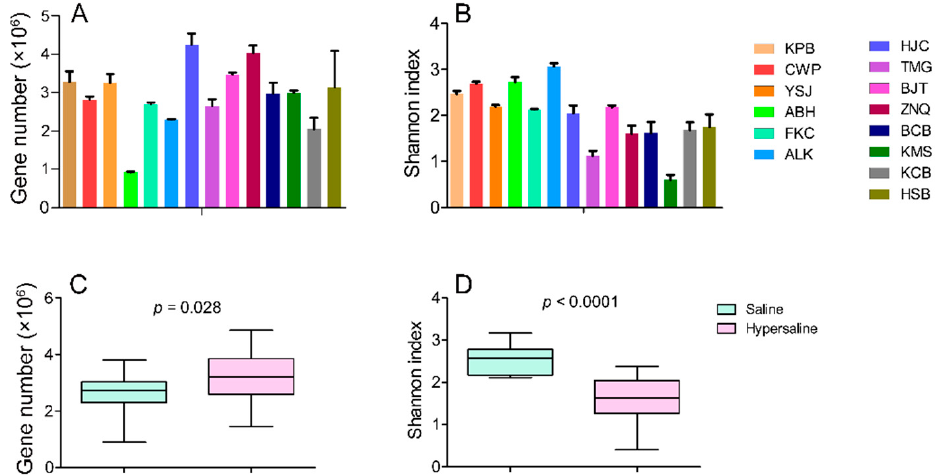
Figure 1. Gene numbers ( A ) and Shannon diversity (at phylum level) ( B ) of microbial communities in each site; and difference in gene number ( C ) and Shannon diversity ( D ) between saline and hypersaline soils.